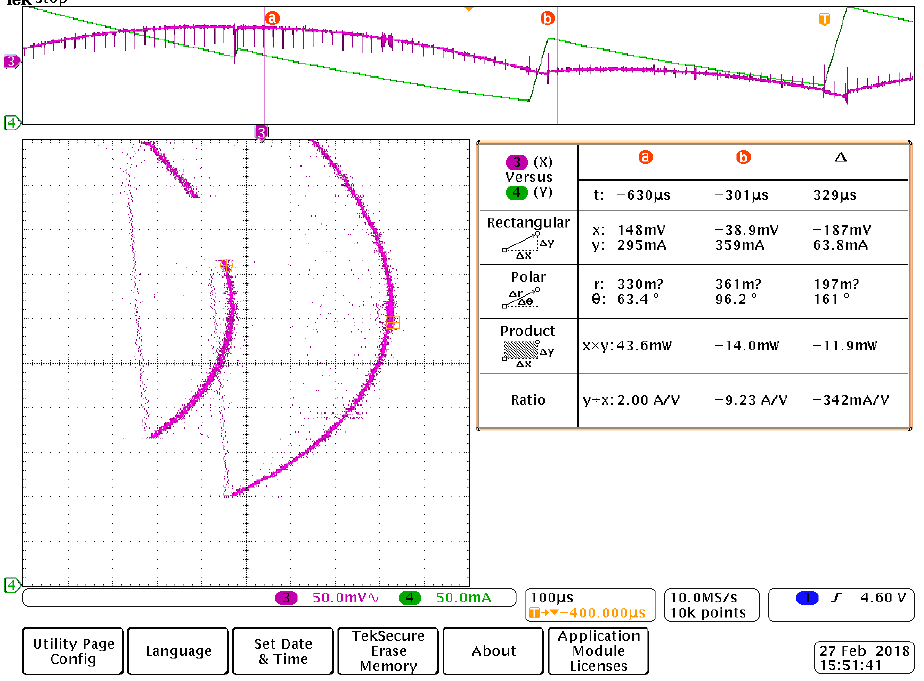
Figure 18. Phase portrait for V g = 17.20, clearly revealing period 2 operation.